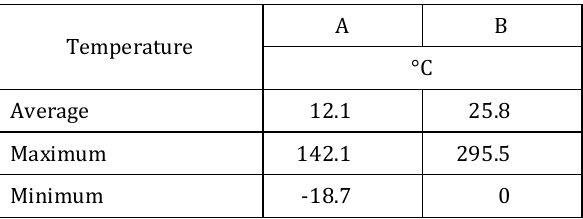
Table 1. Basic parameters of the statistics (A – the spoil tip surface, B – interior of the spoil tip)